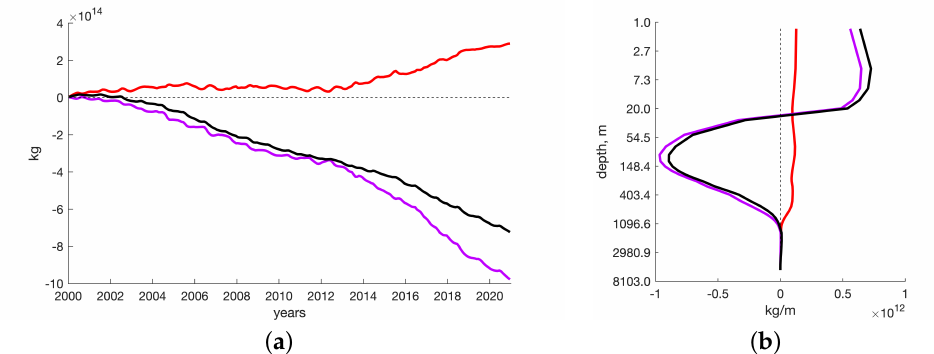
Figure 10. The difference in mass (black curves), heat (red curves), and salt (magenta curves) content in terms of the increment in the mass of water in the Arctic (above 65 N): ( a ) timeseries of the whole content, ( b ) vertical distribution averaged over time in terms of incremental values in numerical experiment B to experiment